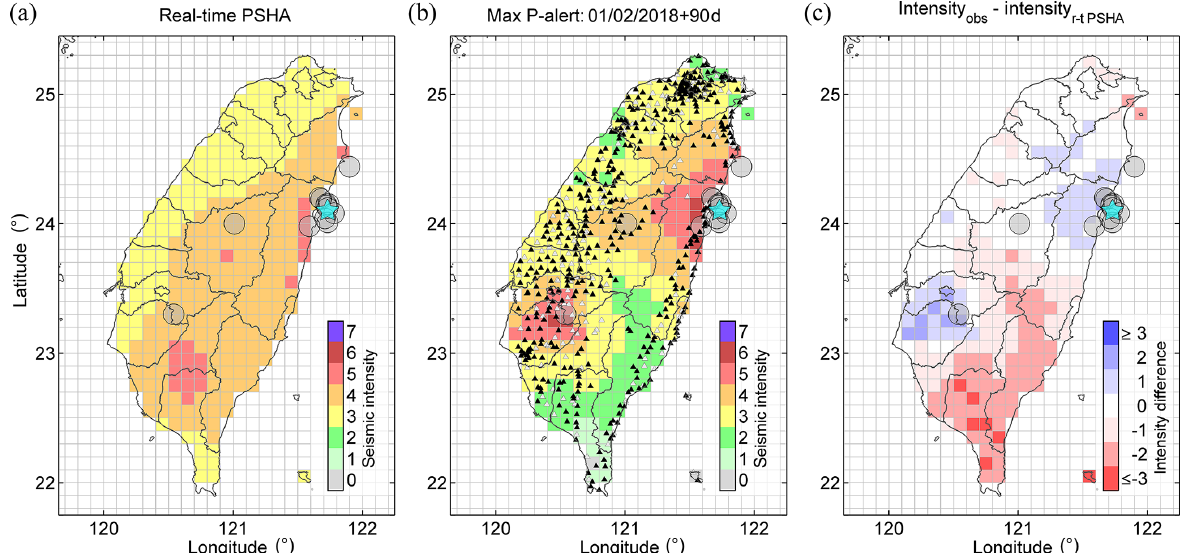
Figure 3. The 2018 Hualien earthquake. (a) Map of forecasting maximum seismic intensity. (b) Map of maximum seismic intensity recorded by the P-alert network. (c) Difference in seismic intensity between the forecast and the record. The cyan star represents the Hualien earth-